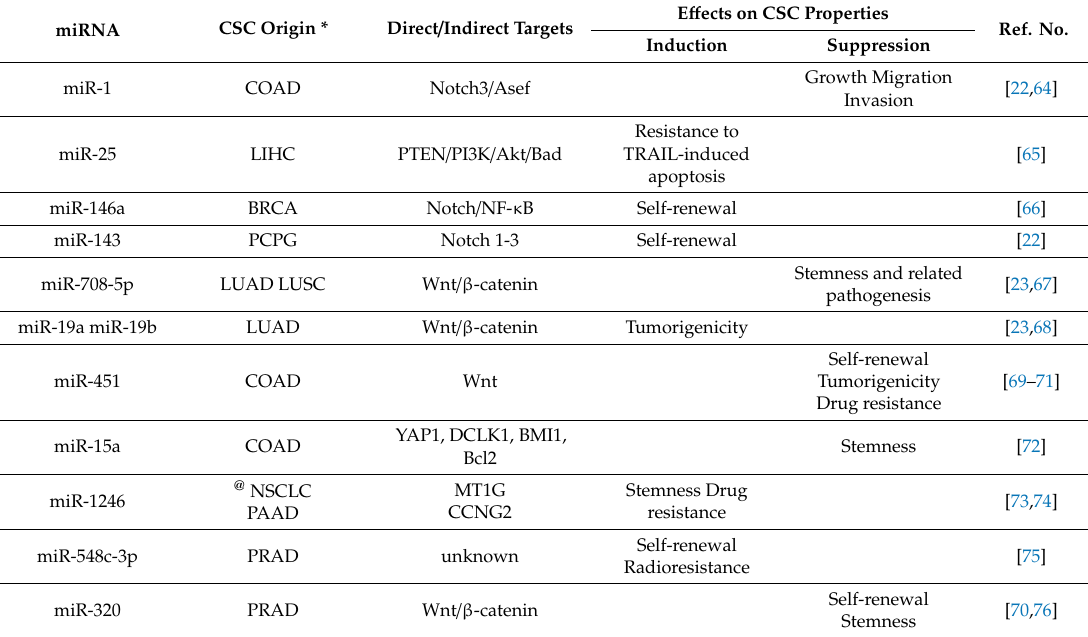
Table 1. Dual roles of microRNAs (miRNAs) in the regulation of cancer stem cell (CSC)-related features. miRNA CSC Origin